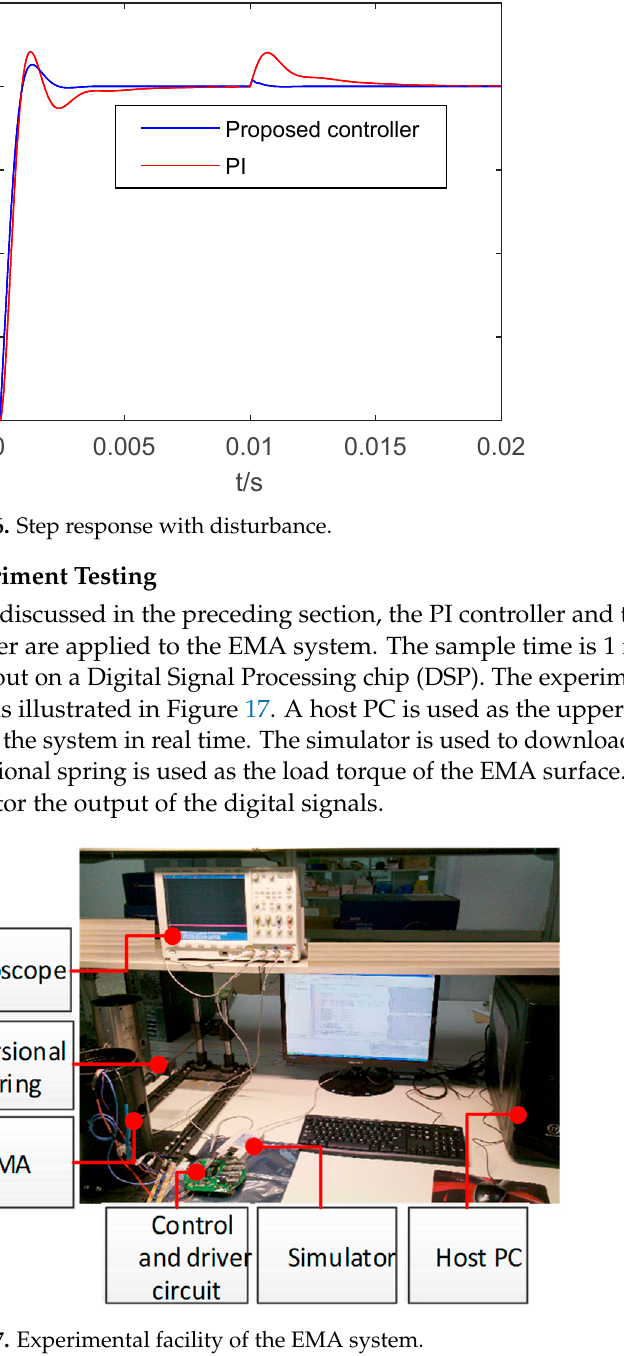
Figure 17. Experimental facility of the EMA system.